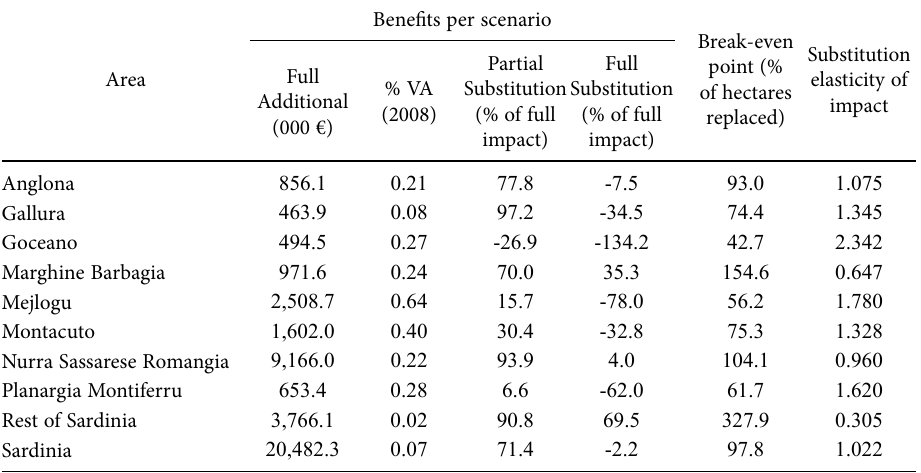
Table 4. Impacts produced by the cardoon supply chain in terms of value added, Sardinia, Italy.